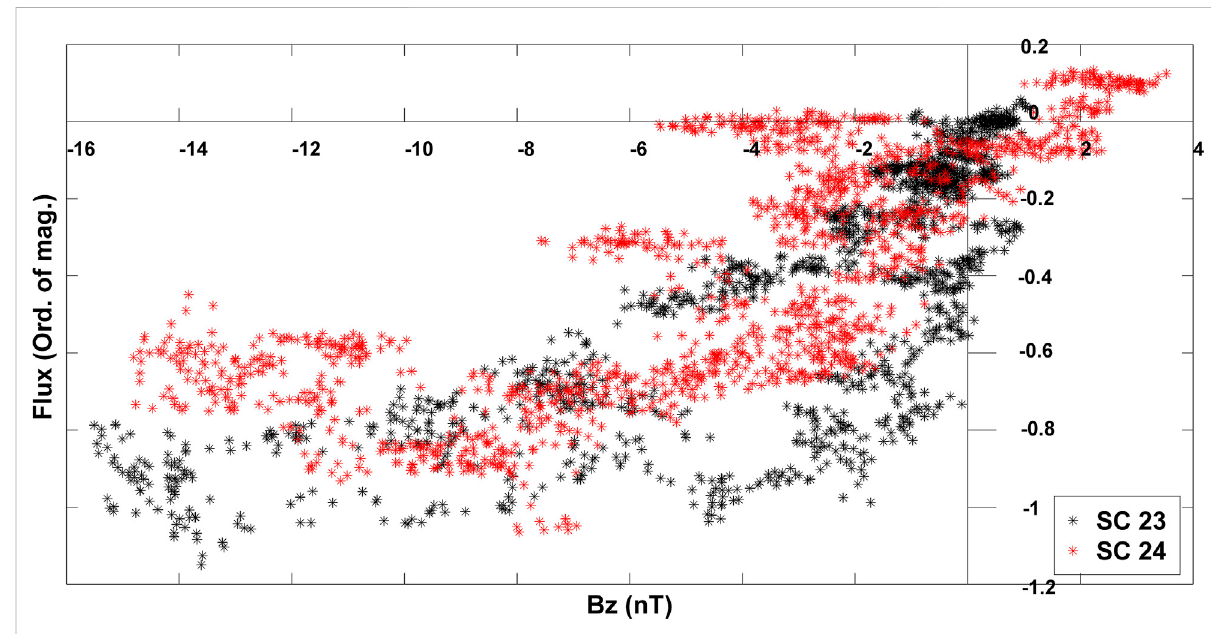
FIGURE 9 Variation of Δ F (in the order of magnitude) with IMF Bz (nT) for storms that occurred during solar cycle 23 (black) and solar cycle 24